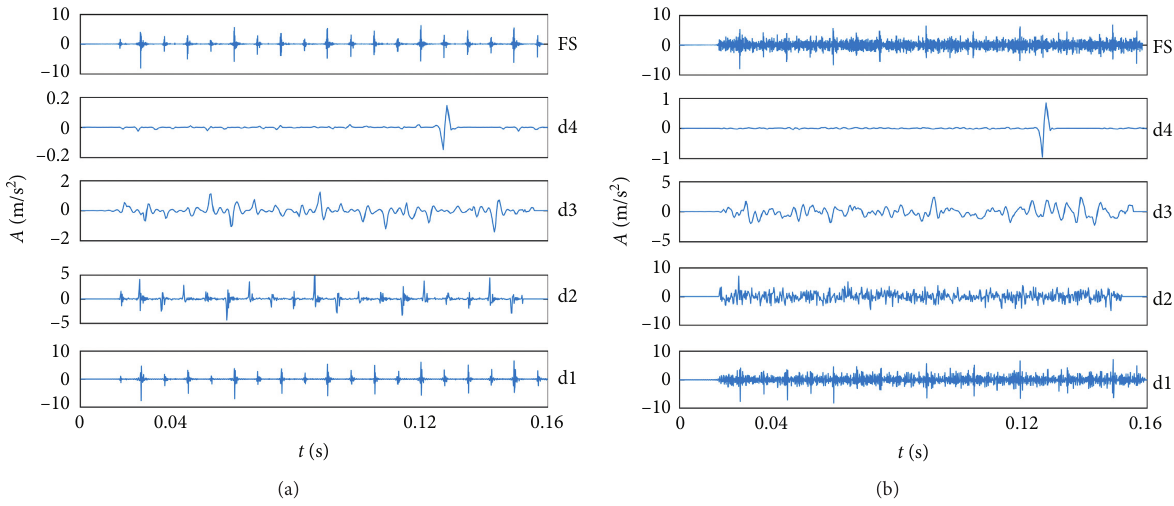
Figure 8: The results of the normal simulation signal processed by wavelet decomposition. (a) Noiseless. (b) Under 5dB